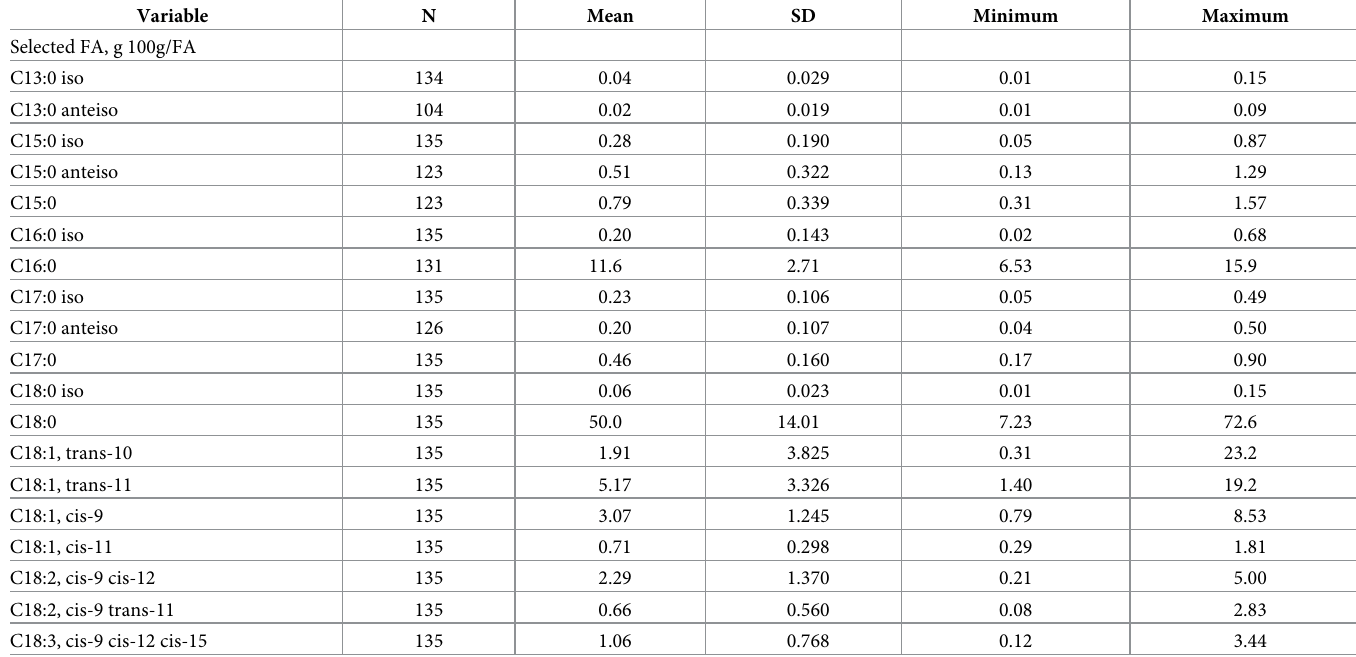
Table 2. Minimum, maximum, mean, and standard deviation values for selected fatty acids (FA) content in omasal digesta in the data set.